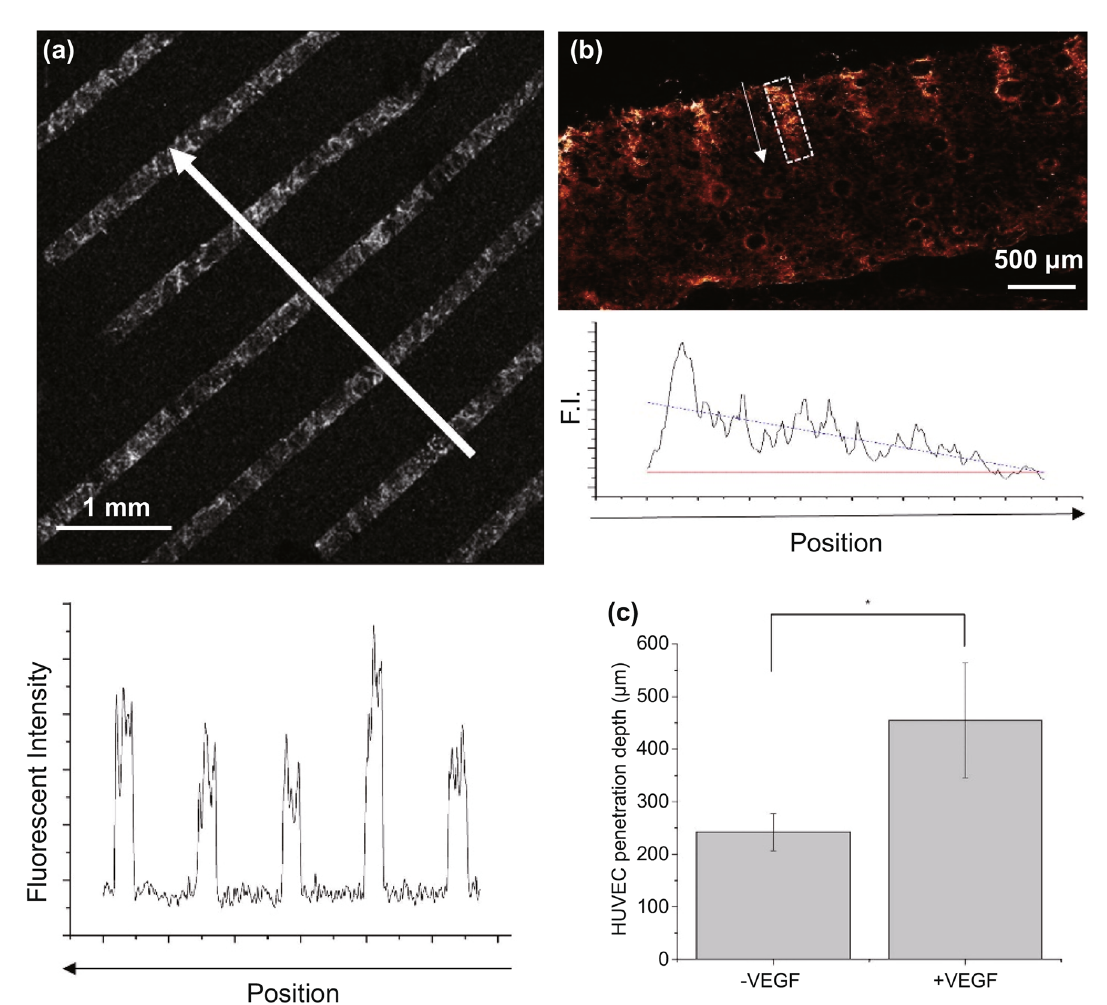
Fig. 4 Photopatterning of VEGF onto the surface of collagen-glycosaminoglycan scaffolds; a the surface of the collagen-glycosaminoglycan scaffolds photopatterned with VEGFs, b cross-sectional microscopy of the photopatterned VEGF onto the surface of collagen-glycosaminogly- can scaffolds, c the VEGF bounded amount onto the surface of collagen-glycosaminoglycan scaffolds